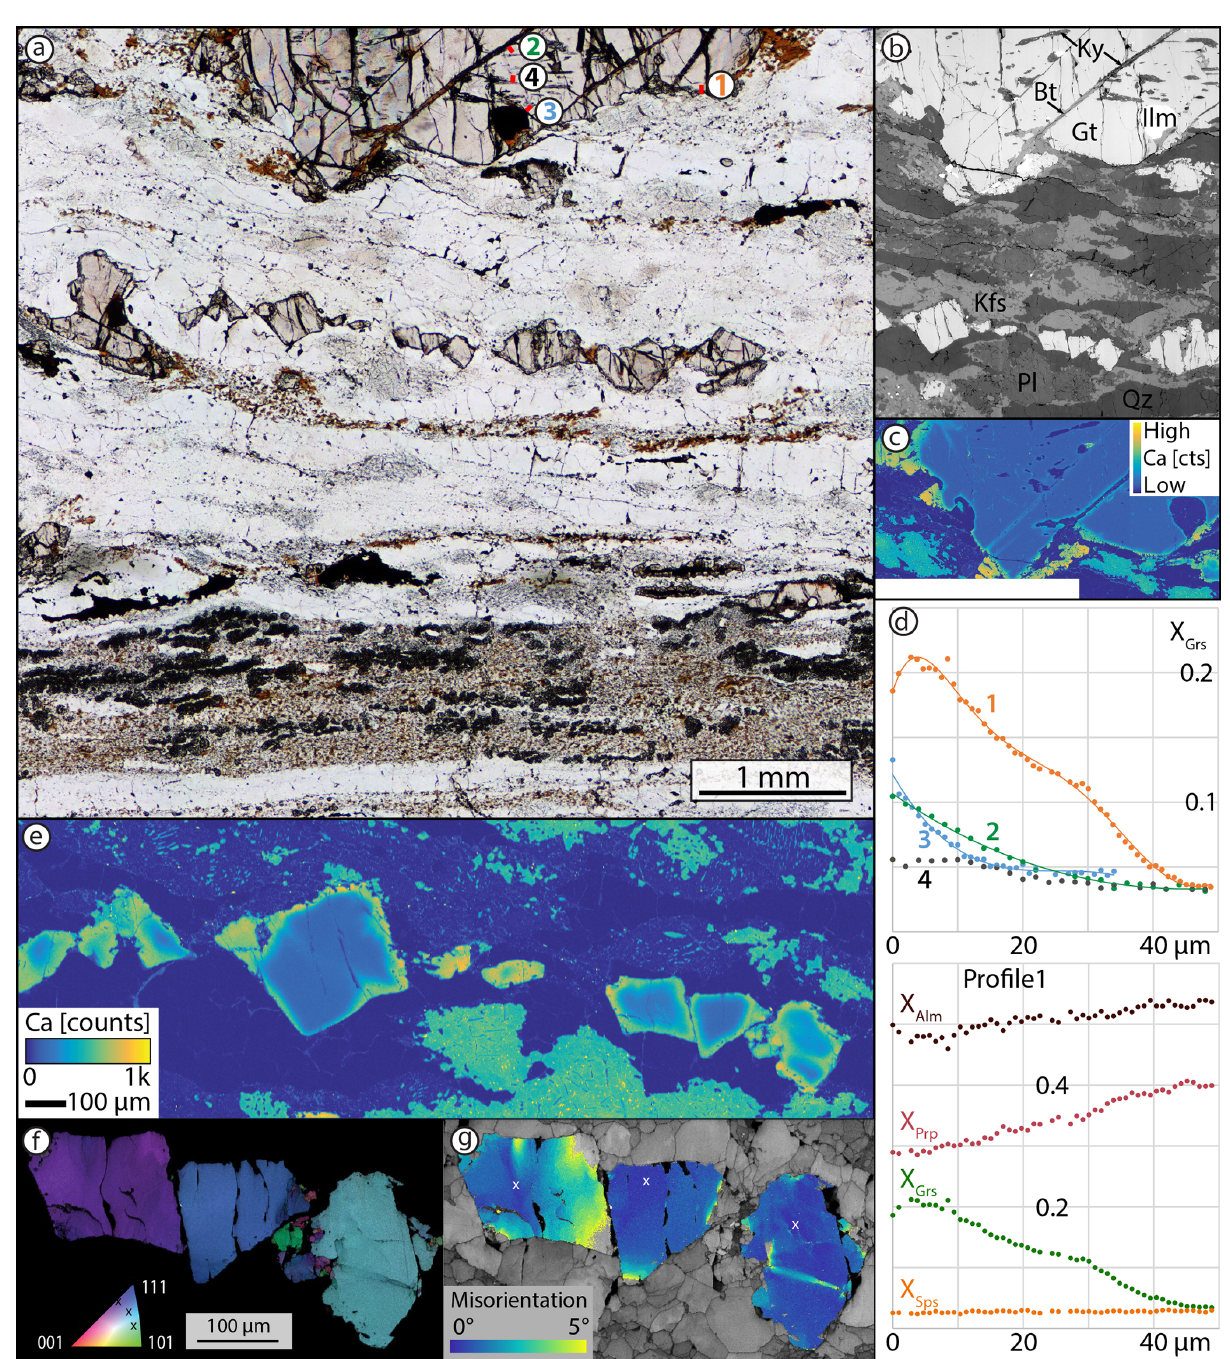
Figure 4. (a) A plane-polarized light image of the thin section with fractured garnets and a pseudotachylyte vein in the lower part of the image. (b) A BSE image of the upper area of (a) , with the same scale as (a) . (c) An EPMA X-ray map for Ca reveals an enrichment in thin gradational rims along grain boundaries and fractures and within neocrystallized garnet (euhedral, orange). (d) Grossular component profiles indicated on (a) (profile lines are not to scale for the sake of visibility) and compositional profiles for four garnet end-members in profile 1. (e) An EPMA X-ray map for Ca for the garnet fragments in the centre of (a) . Note the uneven colours in the plagioclase and the blue kyanite needles. (f) An inverse pole figure map with a superimposed image quality map for garnet fragments shows a common rotation pole. (g) Misorientation map relative to the reference point for each fragment reveals internal lattice